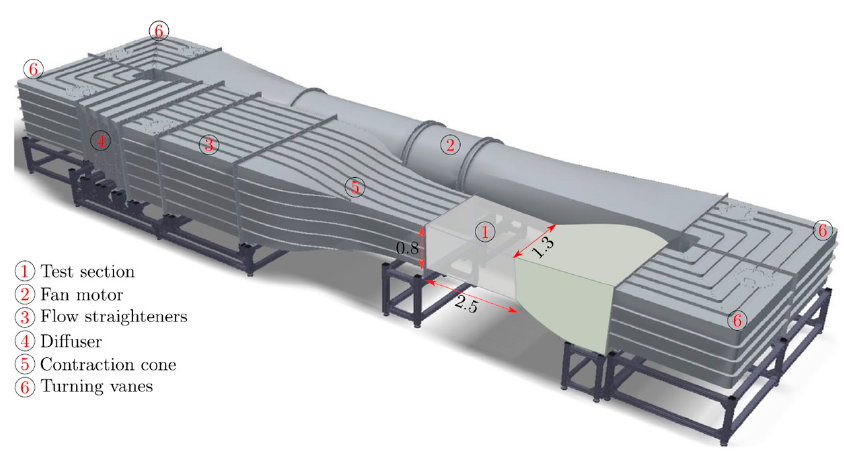
Figure 7. Three-dimensional model of the wind tunnel facility at Bauhaus-Universität Weimar [39].